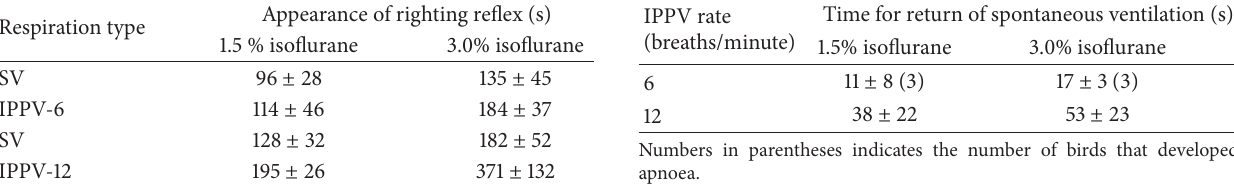
Table 7: Mean time ± SD for the return of spontaneous breathing in 6 sulphur-crested cockatoos ( Cacatua galerita galerita ) during recovery from 1.5% and 3.0% isoflurane anaesthesia after intermit- tent positive pressure ventilation (IPPV).